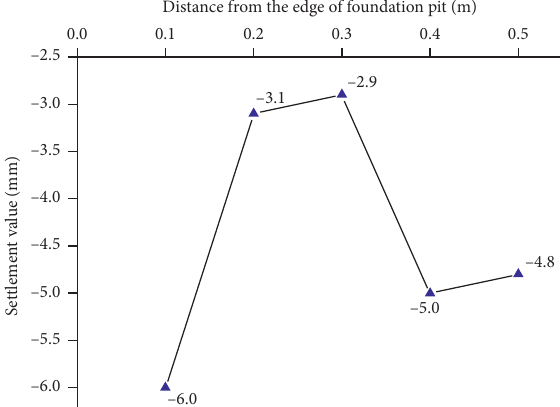
Figure 32: Surrounding ground settlement value when the wharf is excavated to the